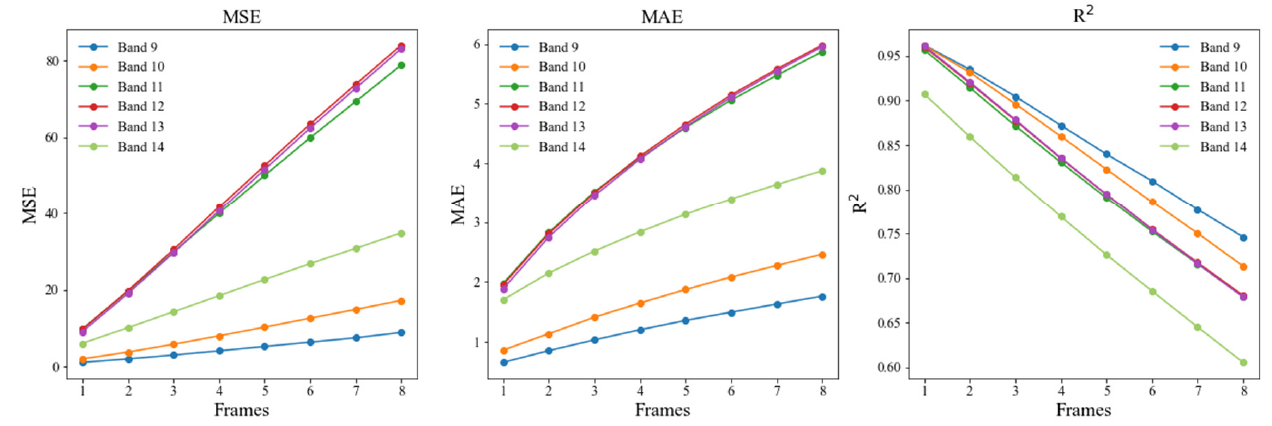
Figure 10. The prediction evaluation results for Band 9 to Band 14.